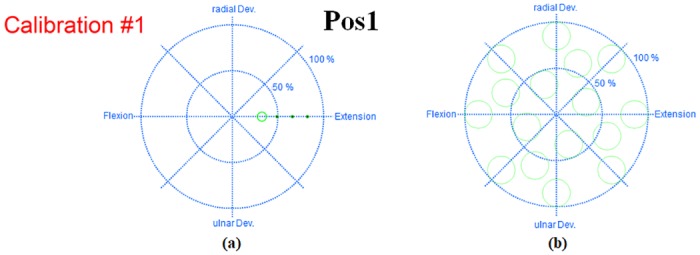
Graphical user interface (GUI) of the implemented online myoelectric control system.(a) Screen shot of the calibration run. At the beginning of the calibration run, three small circles sequentially start moving to a predefined direction corresponding to one of the two DoF wrist movements (flexion-extension and radial-ulnar deviation), during which the subject is asked to wait for an upcoming a larger circle. The three small circles are introduced to give the subject a preparation time, and the larger circle is the actual visual target the subject should follow. When the larger circle appears and starts following the three small circles, the subject is prompted to make wrist contractions based on the position of the larger circle moving from the center (rest position) to the end point of the outer circle (full contraction). The time used for each direction is 8 s, which consists of 3 s movement from the center to the end position, 2 s dwell time at the end position, and 3 s returning movement to the center. The target circle (larger one) is sequentially presented to extension, radial deviation, flexion and ulnar deviation direction. (b) Location of all 16 targets used in the online evaluation run. At the beginning of the online test run, a pink cursor first appears in the center for 3 s, and then a target is randomly presented with a pure-tone beeping sound, which is the signal to start performing the task. To acquire a target, the cursor should be entered into the circle within a time limit and stayed for 1 s. The time limit is set to 5 s for the preliminary experiment and 10 s for the main experiment, considering task difficulty after arm position change and donning/doffing. After the subject hits or misses a target, the cursor is automatically returned to the center and a new target is given to the subject with the beeping sound. There is a 1-s pause between targets for the subject to prepare the next acquisition task. This procedure is iterated for all 16 targets. The targets are presented with differently randomized orders for each evaluation run and each subject.